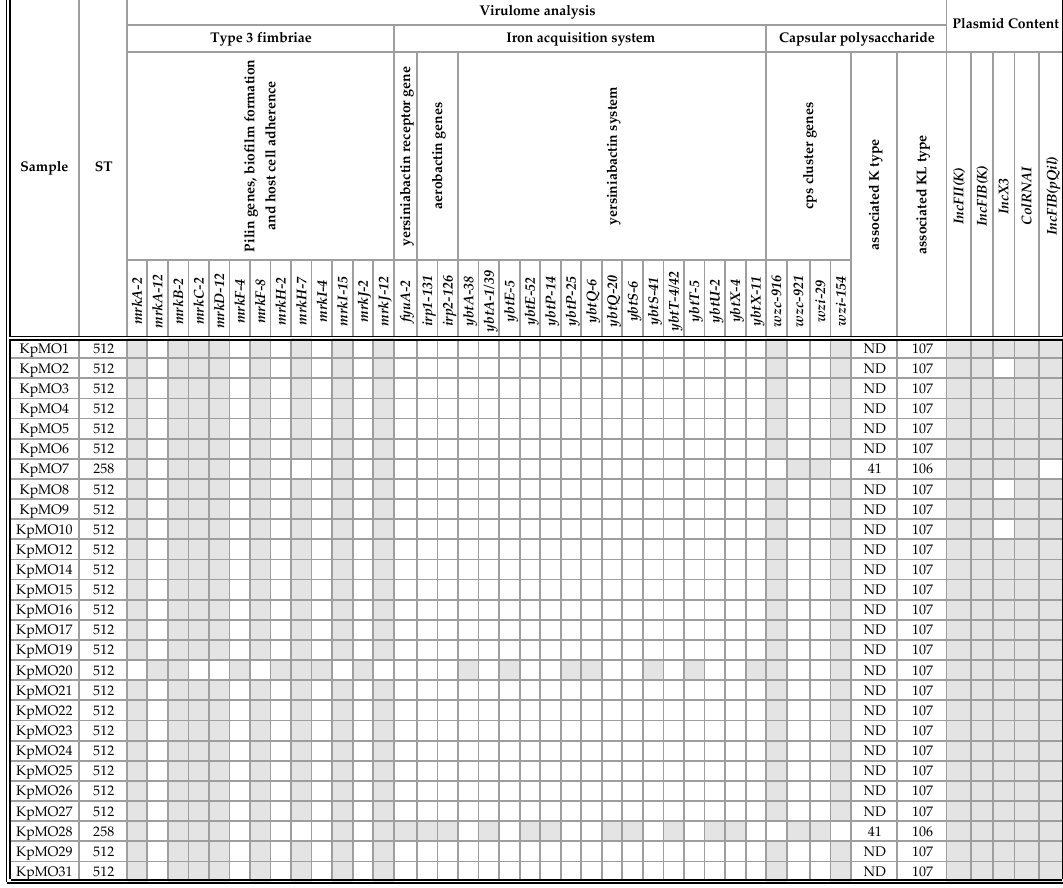
Figure 2. Virulome data and plasmid content. Virulome data were obtained by Pasteur MLST Kp database; plasmid content data were obtained by PlasmidFinder-1.3. Grey and white colors represent gene presence and absence respectively. ND, Not Defined.